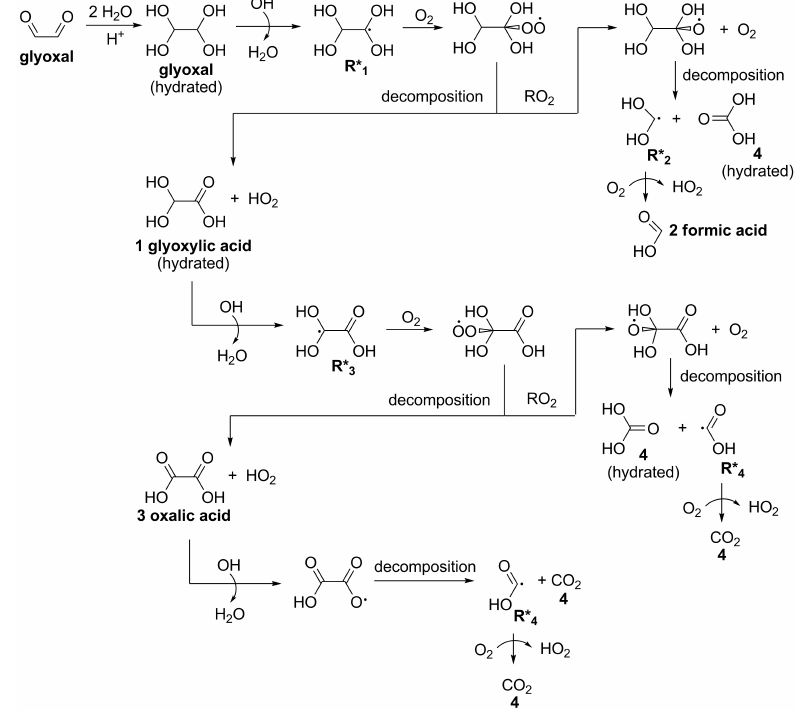
Fig. 2. Mechanism for aqueous-phase reaction of glyoxal with OH